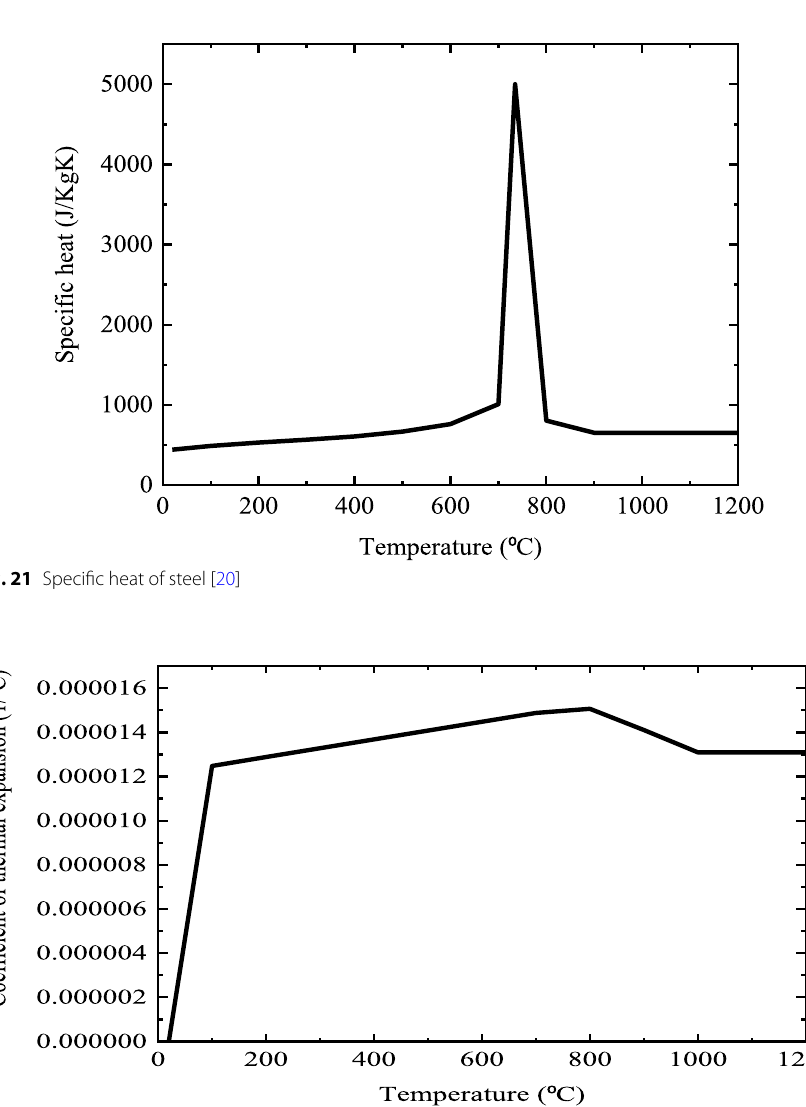
Eurocode-2-part1-2. The density of reinforcing steel at ambient temperature used in the study ρ (20 ° C ) is 7850 kg/m 3 . The last thermal property of reinforcing steel at elevated temperature is thermal strain and coefficient of thermal expansion Fig. 22 depicts the coefficient of thermal expansion of steel at elevated temperatures. The thermal strain, ℇ s ( ϴ ) of steel may be determined from the following equations with reference to the length at 20